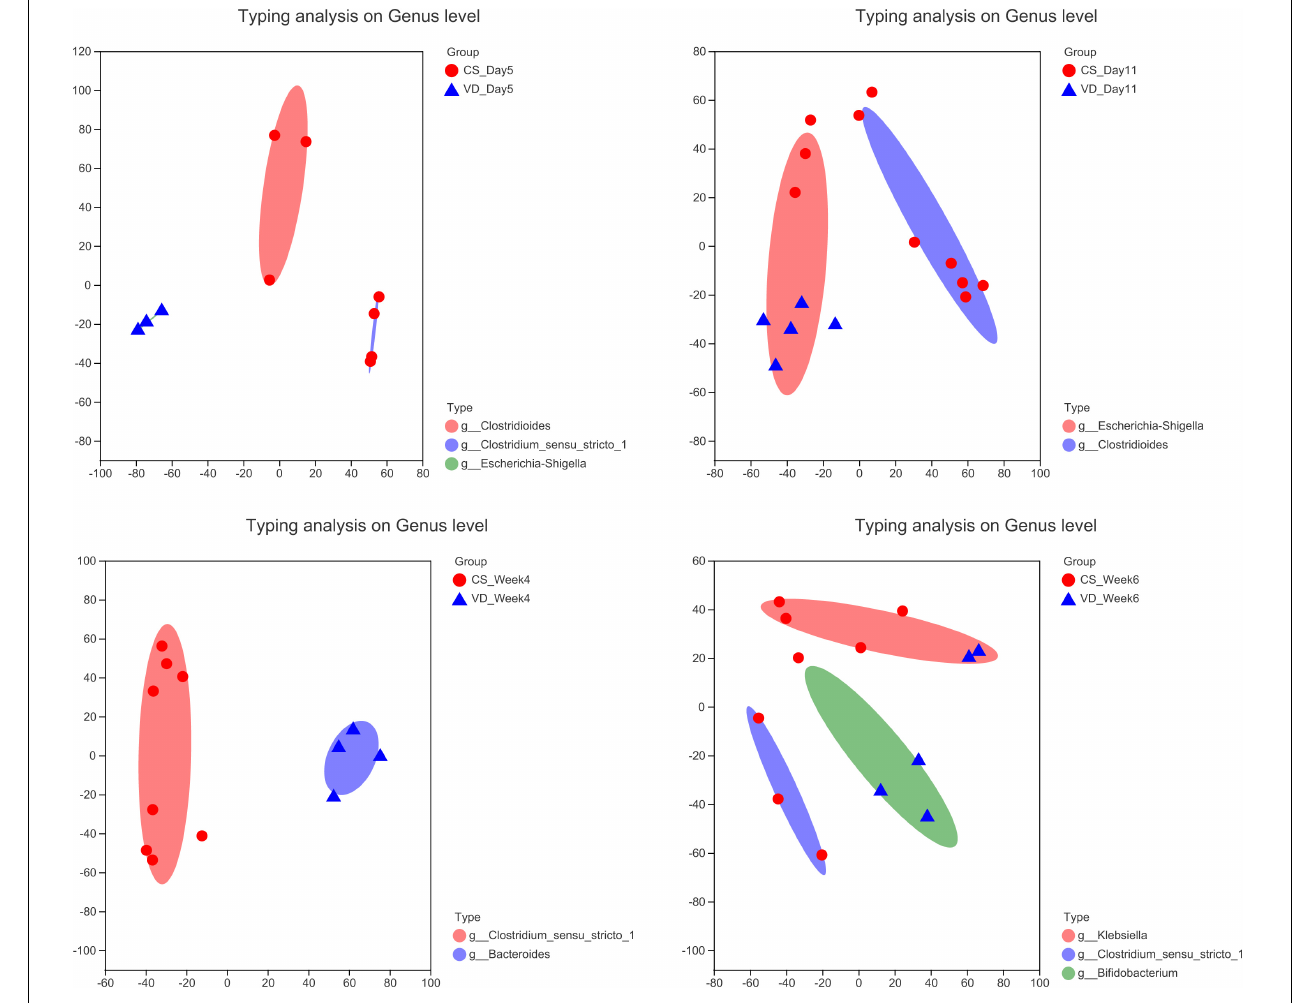
FIGURE 8 | Enterotype analysis of gut microbiota based on delivery mode at different stages.